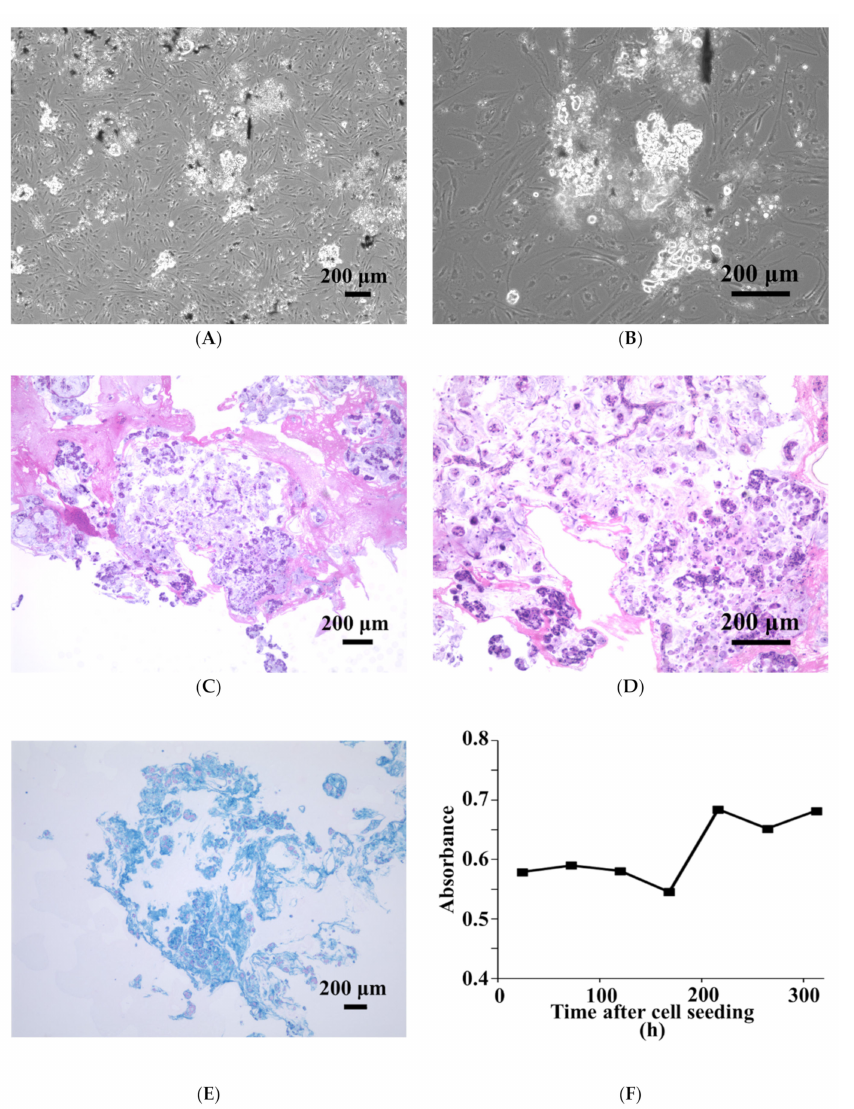
Figure 4. Characterization of NCC-PMP1-C1 cells. ( A , B ) NCC-PMP1-C1 cells exhibiting a pleomor- phic morphology in phase-contrast micrographs. ( C – E ) NCC-PMP1-C1 cells were resuspended and embedded in agarose, then sectioned and examined using H&E ( C , D ) and Alcian blue staining ( E ). ( F ) Growth curve of NCC-PMP1-C1 cells. All scale bars indicate 200 µ